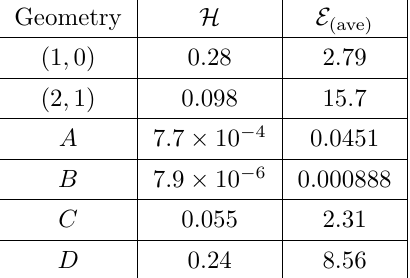
Table 2. Several mixed mass-current (dimensionless) multipole ratios for the asymmetric pincers of section 4.3.1,computed using the direct BPS and the indirect methods.